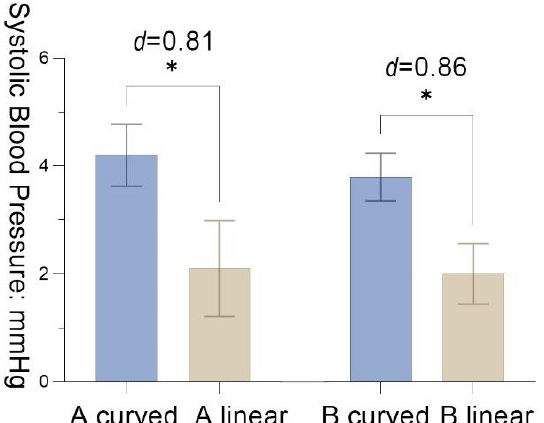
Figure 7. The results of systolic blood pressure with the standard error mean bars; significance lev- els: * p < 0.05; effect size (d): negligible (<0.2), small (0.2 – 0.5), moderate (0.5 – 0.8), and large effect (>0.8).